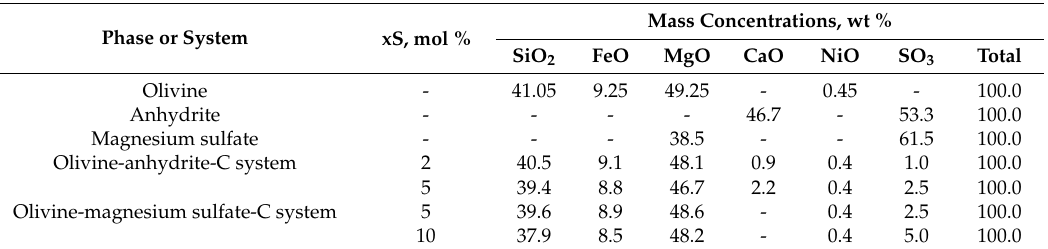
Table 1. Composition of initial olivine, sulfates, and bulk compositions of the systems (wt %).